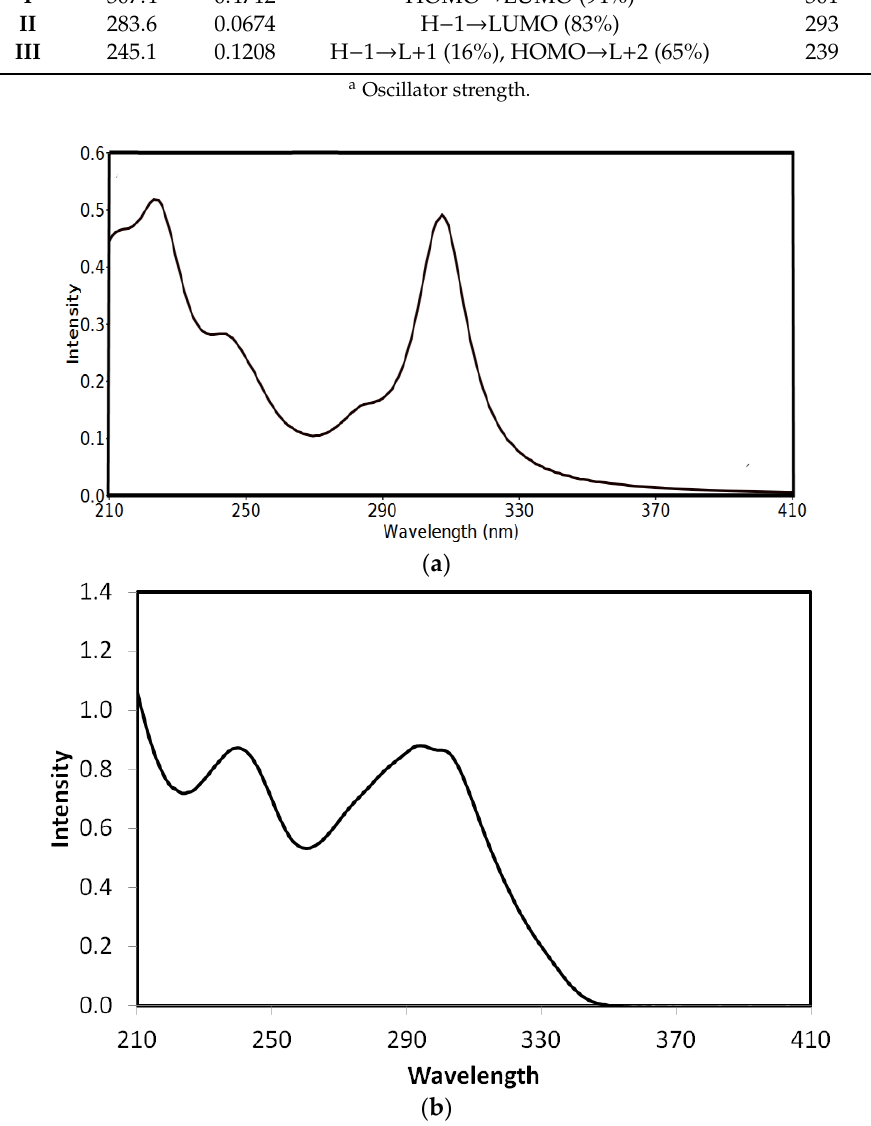
Figure 12. The correlation UV-Vis chart of the desired molecule via employment of the TD-DFT/B3LYP method ( a ) and the experimental results ( b ).